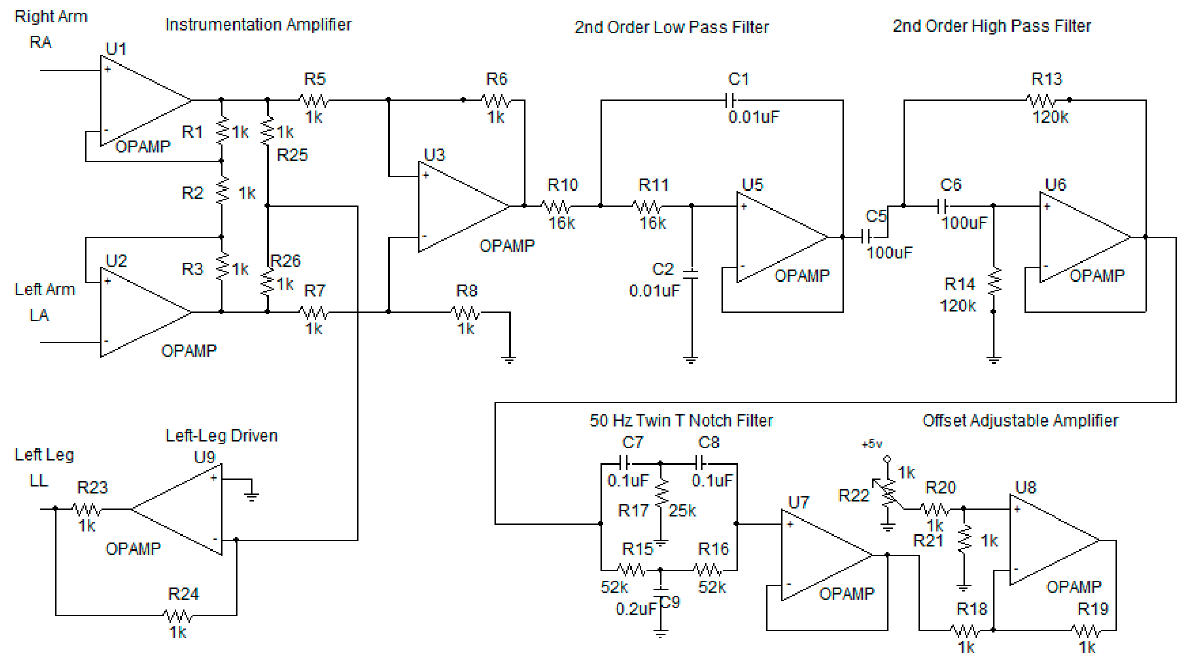
Figure 1. Electrocardiogram (ECG) acquisition circuit.